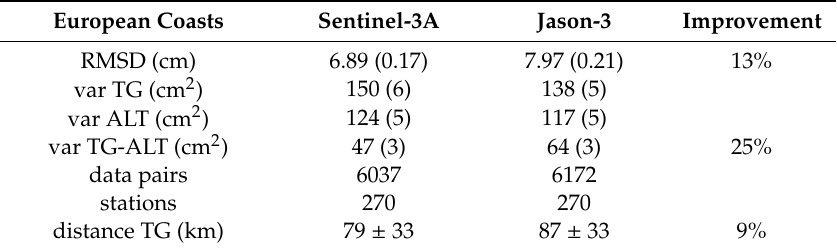
Table 1. Inter-comparison of the satellite altimetry and tide gauge data from the European coasts in terms of the RMSD (cm) and variance (cm 2 ) of the di ff erences between both datasets. The number of tide gauge stations used in the comparison, the mean distance between tide gauges and the most correlated along-track altimetry points, and the number of total data pairs (altimetry-tide gauge) used in the computation are displayed. The common tide gauge stations for the Sentinel-3A and Jason-3 satellite missions were used. Values in parenthesis show the uncertainties (error bars) computed for the RMSD and variance from the bootstrap method using 10 3 iterations. Finally, the improvement (%) of the Sentinel-3A data in comparison with tide gauges in terms of lower RMSD, lower variance of the di ff erences (altimetry-tide gauge), and lower mean distance between the most correlated altimetry point and tide gauges with respect to Jason-3 is also displayed. SLA measurements without filtering have been